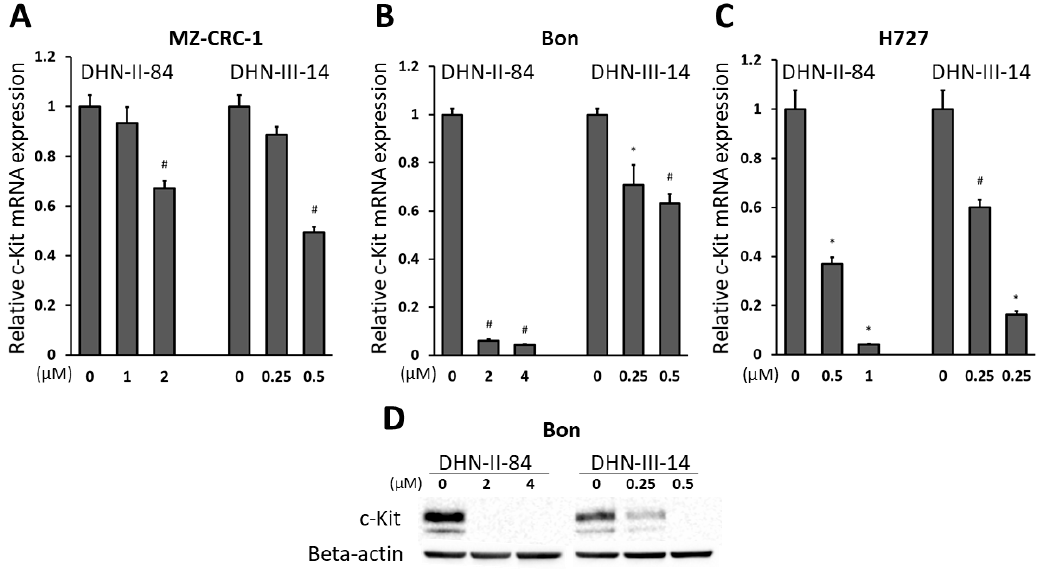
Figure 8. DHN-II-84 and DHN-III-14 decrease c-Kit expression in MZ-CRC-1 ( A ), BON ( B ) and H727 ( C ) cells. The mRNA level of c-Kit was quantified by RT-qPCR in the cell lines following the treatment with DNH-II-84 and DNH-III-14 with half-IC 50 and IC 50 concentrations. The expression levels of mRNA are plotted relative to no treatment. All values are presented as mean relative fold ± SEM (* p < 0.05 and # p < 0.01). ( D ) Western blot demonstrating a basal expression level of c-Kit protein in BON cells and its reduction with DHN-II-84 and DHN-III-14 treatment.